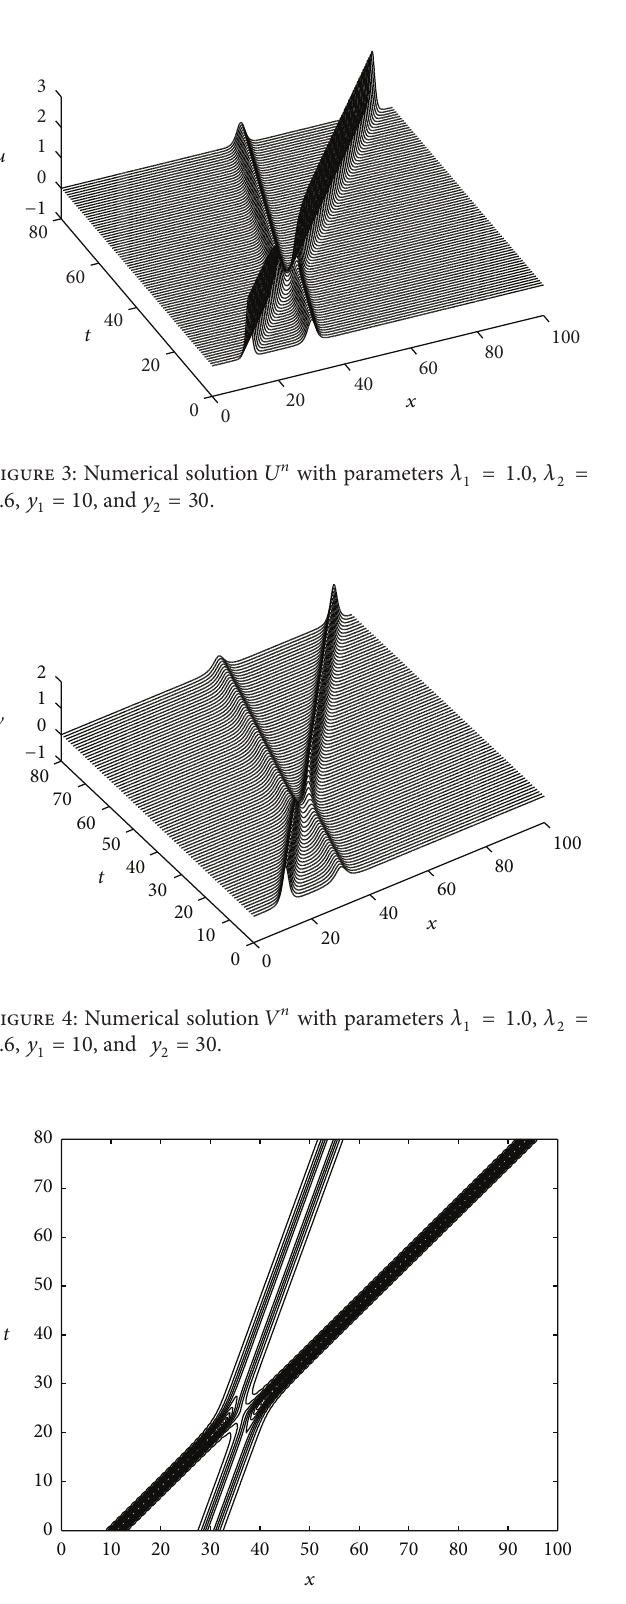
Figure 5: Contours of the numerical solution 𝑈 𝑛 (interaction of two solitons).